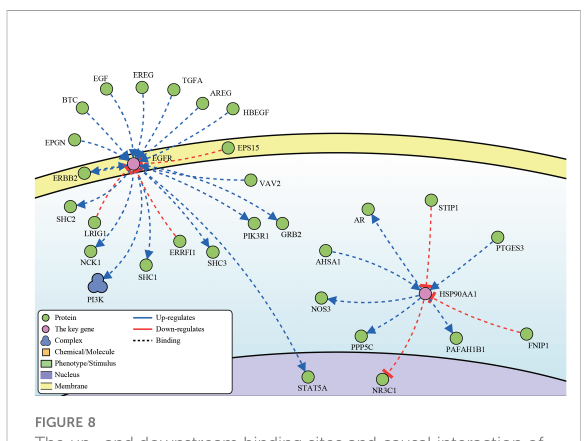
FIGURE 8 The up- and downstream binding sites and causal interaction of the key genes ’ analysis in